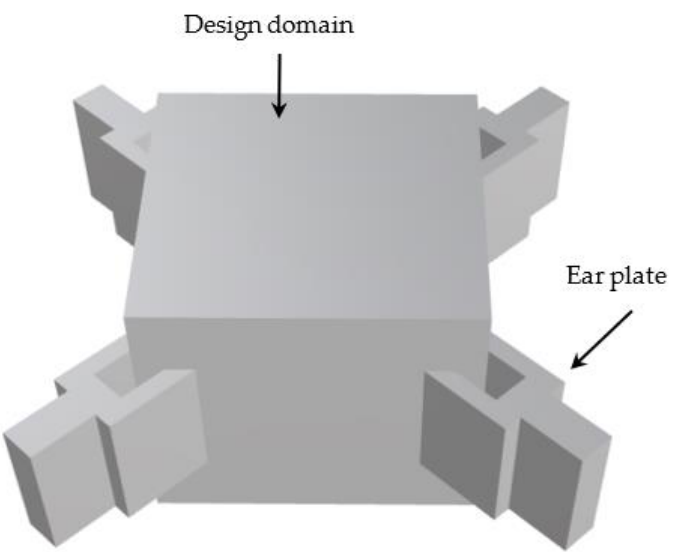
Figure 3. The node model established using the 3D design software Rhino, including the design domain and the part of the lug for applying the load.